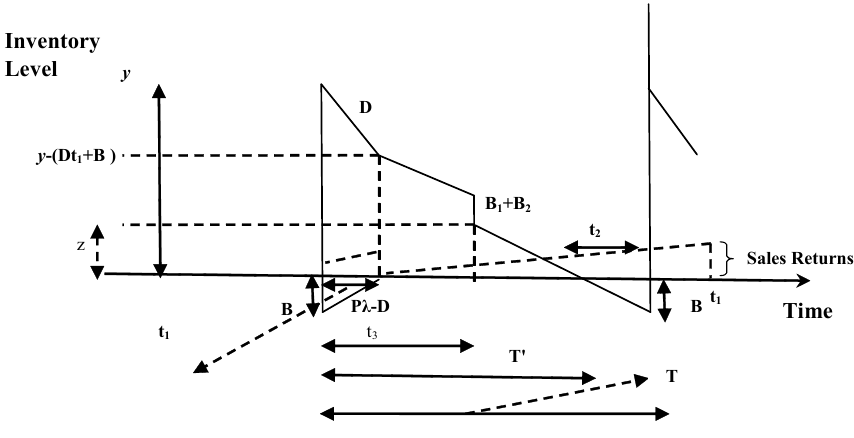
Figure 2. Inventory behavior of the system.